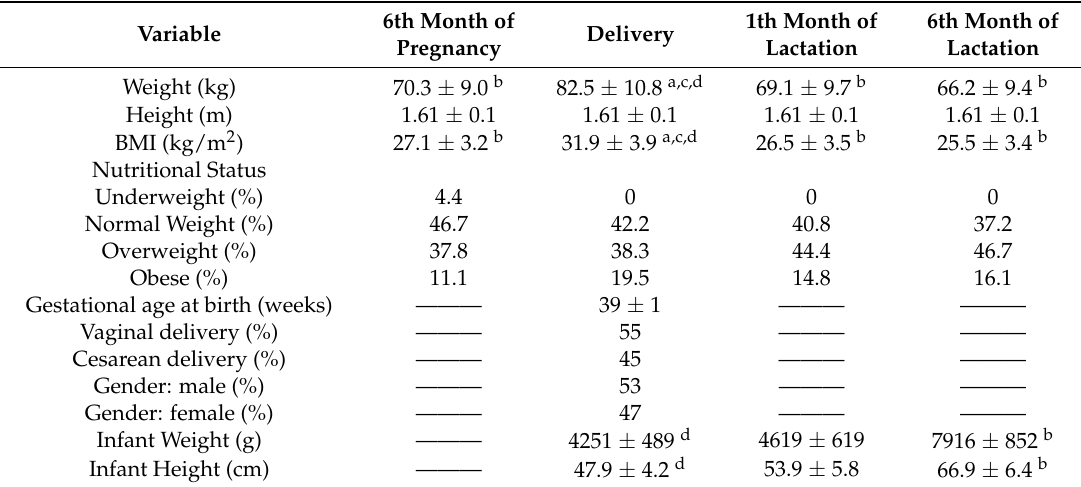
Table 2. Anthropometric characteristics of the women during the pregnancy and lactation